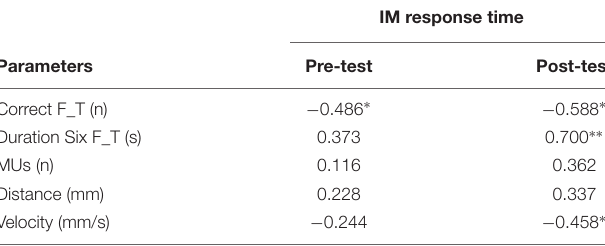
TABLE 3 | Correlations between the IM response time (means based of 14 IM standard tasks) and stepping-task parameters (means based on number